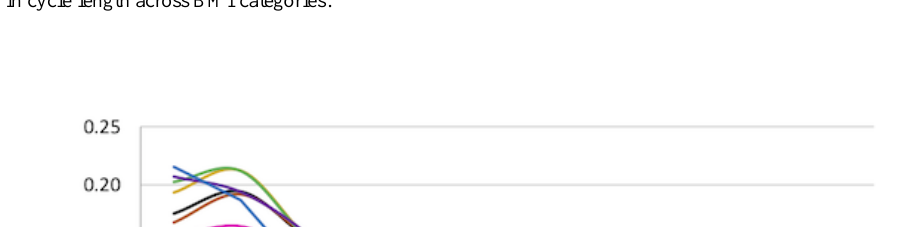
Figure 4. Variation in cycle length across BMI